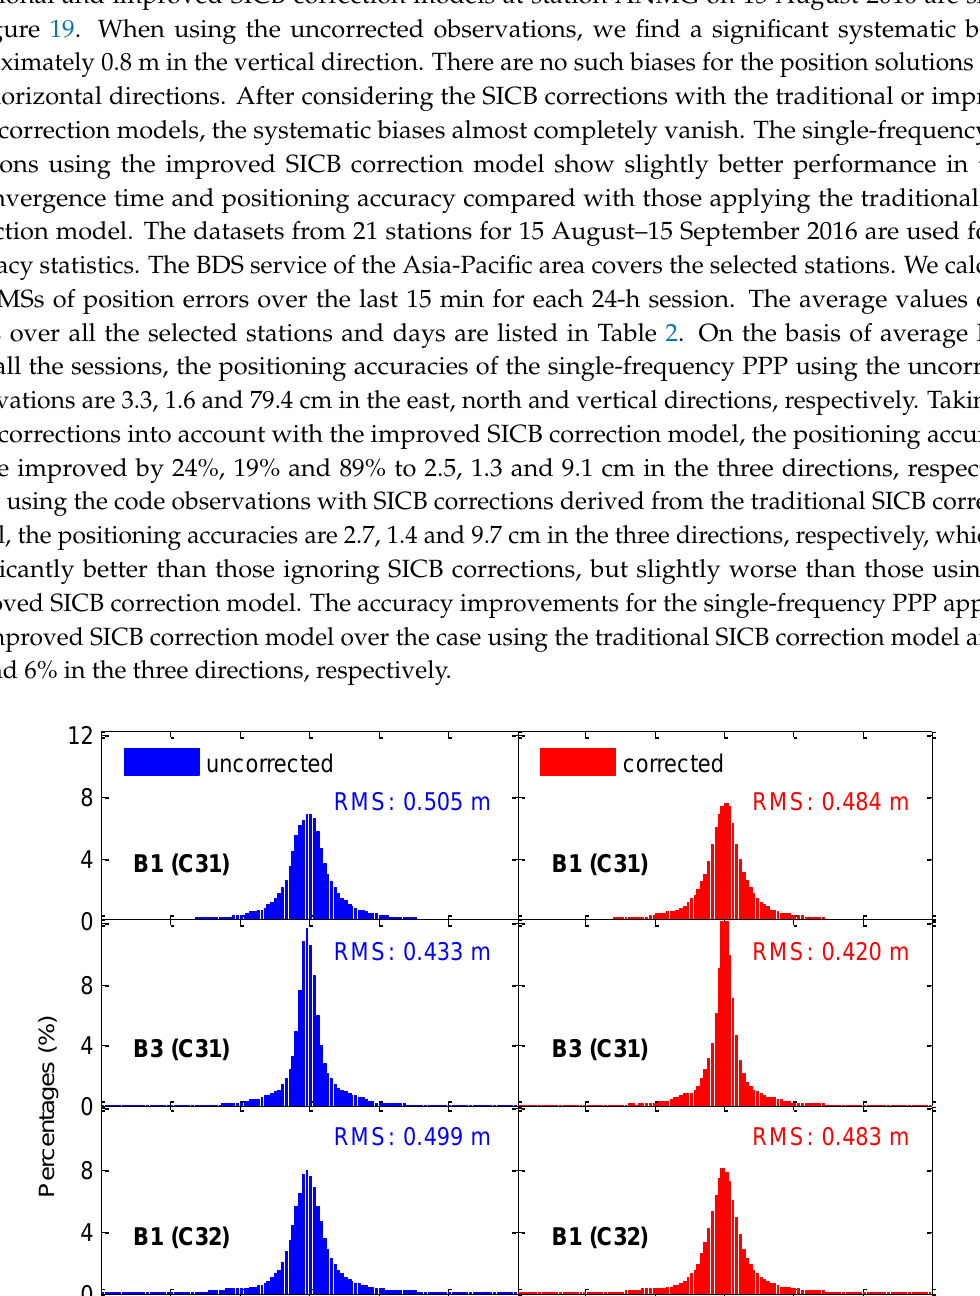
Figure 17. Distribution of uncorrected and corrected MP combination time series for BDS-3S IGSO satellites.